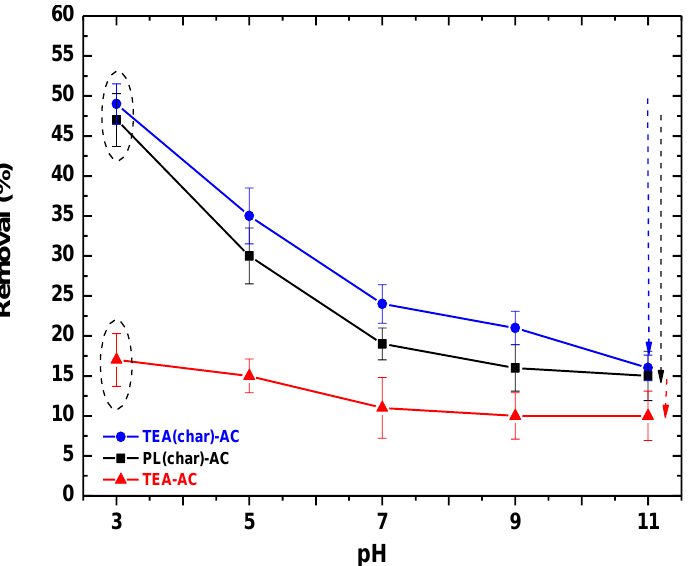
Figure 4. pH effect for the removal of PRM from the liquid phase.